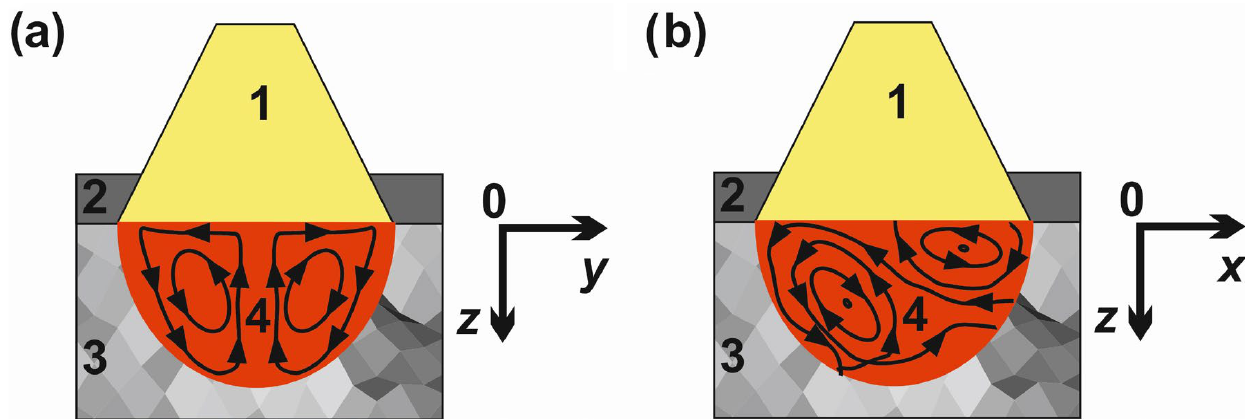
Figure 6. Schematic representation of the direction of convection and vortex motions in a molten pool: ( a ) in the z0y cross-section perpendicular to the direction of the laser beam movement, ( b ) in the z0x cross-section parallel to the direction of the laser beam movement. 1 — laser beam, 2 — pre-coated paste with amorphous boron, 3 — substrate material (Nimonic 80A alloy), 4 — molten pool. XRD patterns of the laser borided Nimonic 80A alloy produced using a laser beam power of 1.3 kW, 1.56 kW, and 1.95 kW are presented in Figure 7. All produced laser re-melted layers contained nickel borides (Ni 2 B, Ni 3 B, and Ni 4 B 3 ) and chromium borides (CrB and Cr 2 B). Some peaks can be identified as Ni, which is justified because , during laser re-